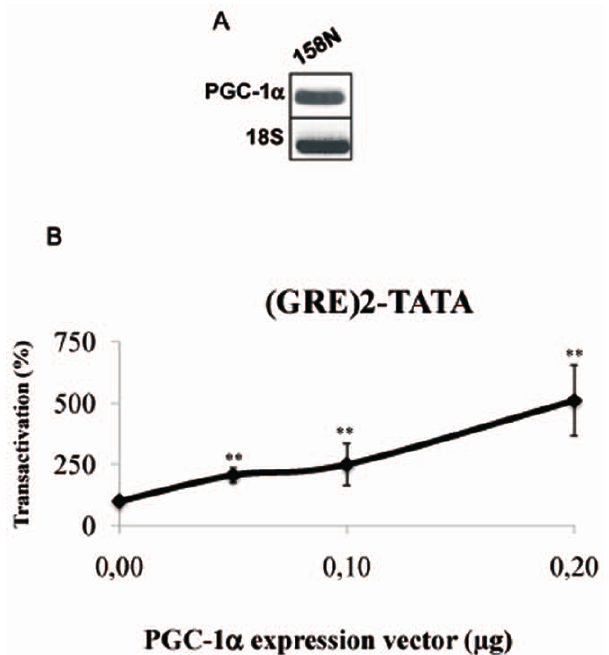
Figure 3. Implication of PGC-1 a in GR transactivation. A/ Expression of PGC-1 a . Total RNA was prepared from 158N cells. RT- PCR experiments were performed using primers recognizing specifically PGC-1 a . PCR products were analyzed on agarose gel (2%) and visualized under UV. 18S RNA was detected by specific primers and used to normalize PGC-1 a expression levels. B/ Implication of PGC-1 a in the glucocorticoid pathway. 158N cells were transiently cotransfected with either 0.2 m g of (GRE)2-TATA-Luc, 0.1 m g of pRSV- b Gal plasmids and increasing amounts of PGC-1 a expression vector, as indicated. Eighteen hours after transfection, cells were incubated with Dex (10 2 6 M) for 24 h, and then luciferase and b -galactosidase activities were analyzed. Results are expressed as percentage of the basal activity and represent the mean + / 2 SEM of at least four independent experiments performed in duplicate. **p , 0.01 when compared between cells transfected with PGC-1 a using Bonferroni’s test after ANOVA.